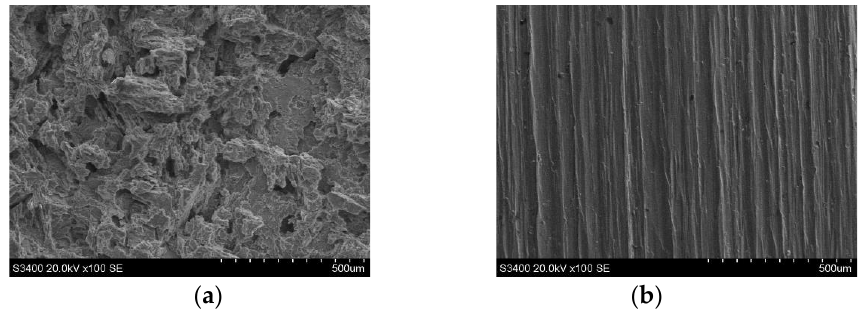
Figure 10. Micro-morphology and roughness of surface groove surface after: ( a ) rough machining, ( b )